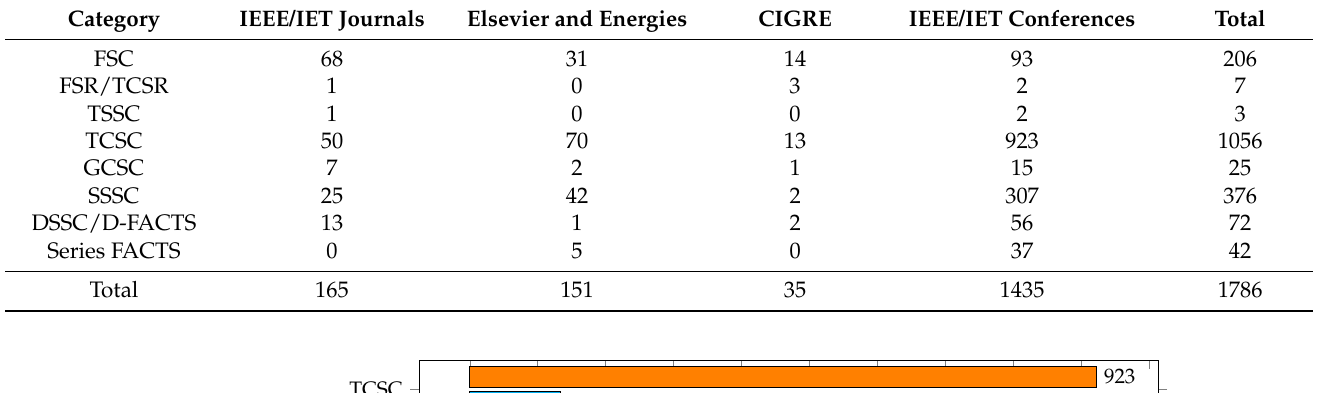
Table 1. Number of publications organized by category and publisher.